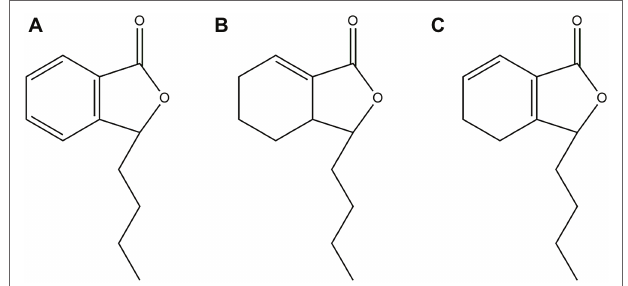
FIGURE 1 | (A) Chemical structure of NBP. (B) Chemical structure of compound1. (C) Chemical structure of